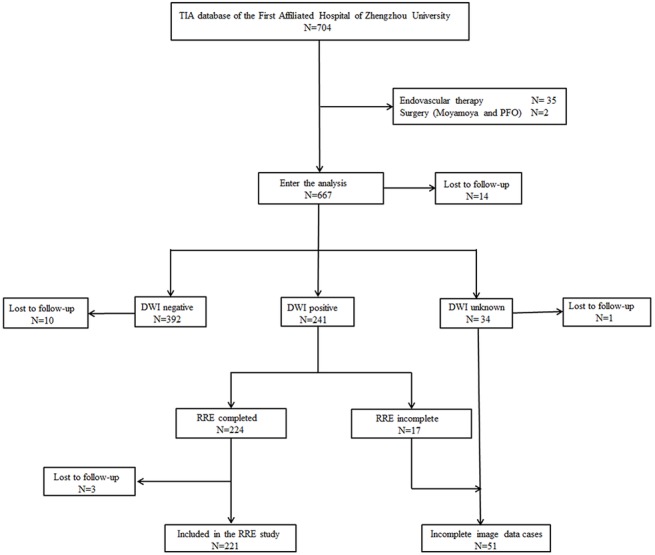
Flow diagram defining the potentially eligible TSI patients.The flow diagram was used to illustrate how the study population was selected.